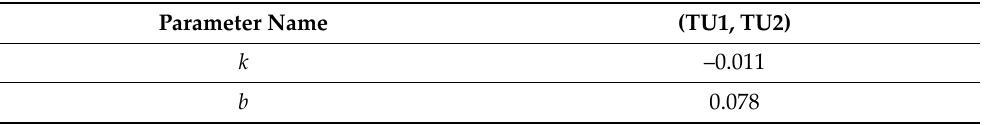
Table 5. Parameters of Equation (25) for various (TU1, TU2) of supplying liquids to MRISF‑2 ( Q is in